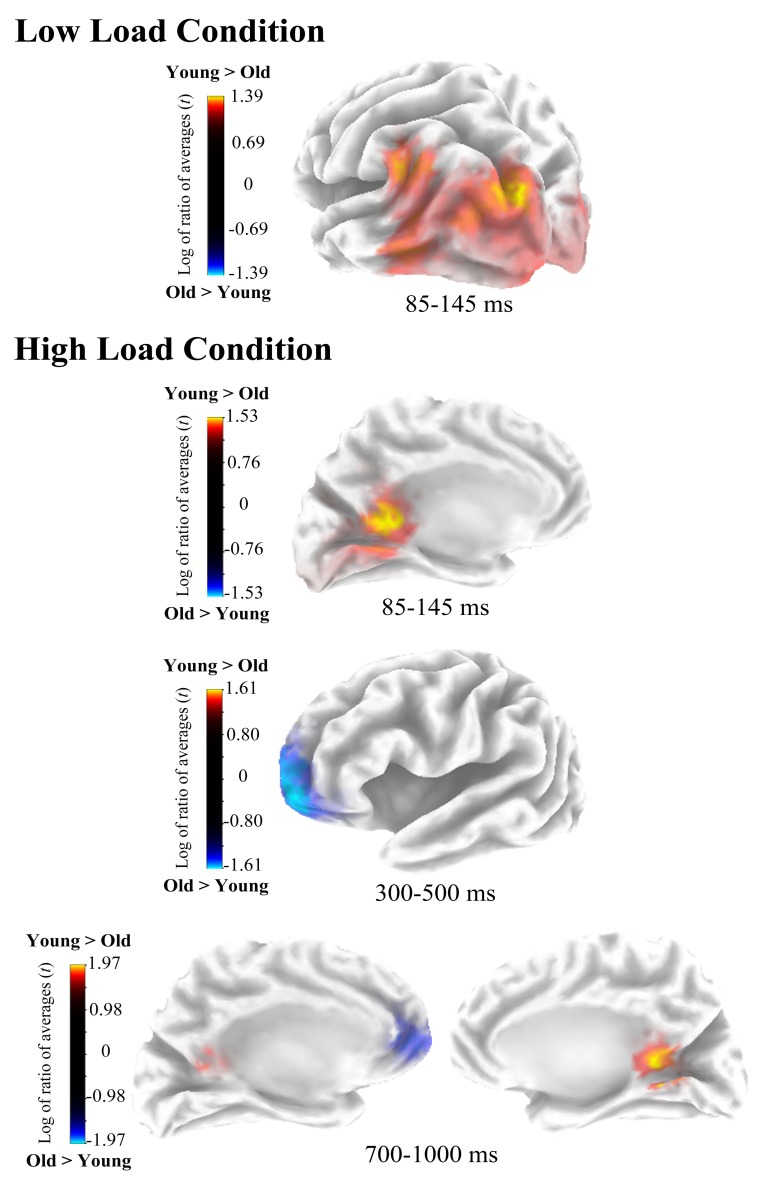
Estimated sources of activation differences between age groups.On top, cluster of voxels showing age-group differences in the low load condition, and on the bottom age group differences in brain electrical activity at source space in the high load condition.